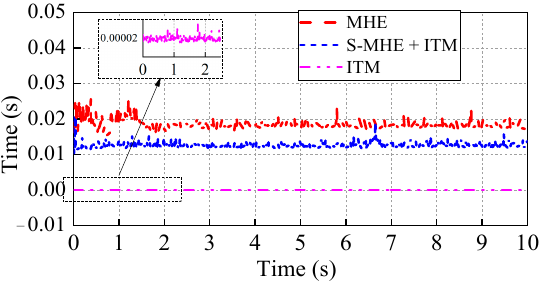
Figure 16. The computation time.